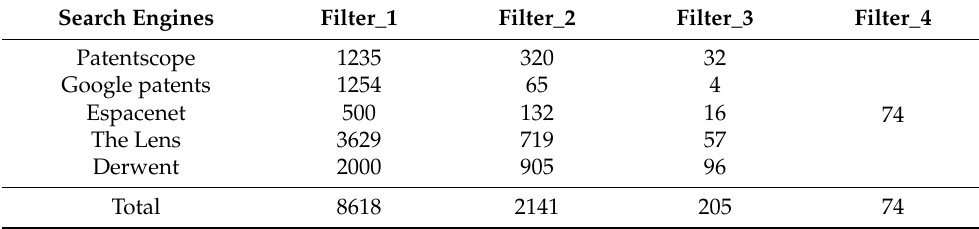
Table 1. Results of the patent search.